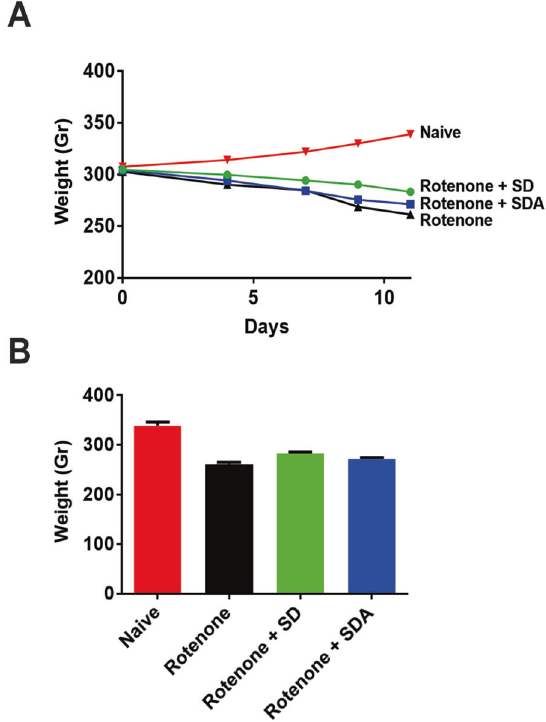
Fig. 2 The effect of rotenone, rotenone + SD, and rotenone + SDA on body mass. A Daily intraperitoneal rotenone (3 mg/kg) for 9 days elicits moderate change in body mass from day 0 to day 10 in rats (300 g; n = 6). B Quanti fi cation of body mass taken at day 0, 4, 7, and 10 after rotenone